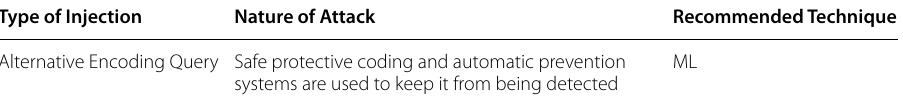
Table 7 Alternative encoding query [54] Type of Injection Nature of Attack Recommended